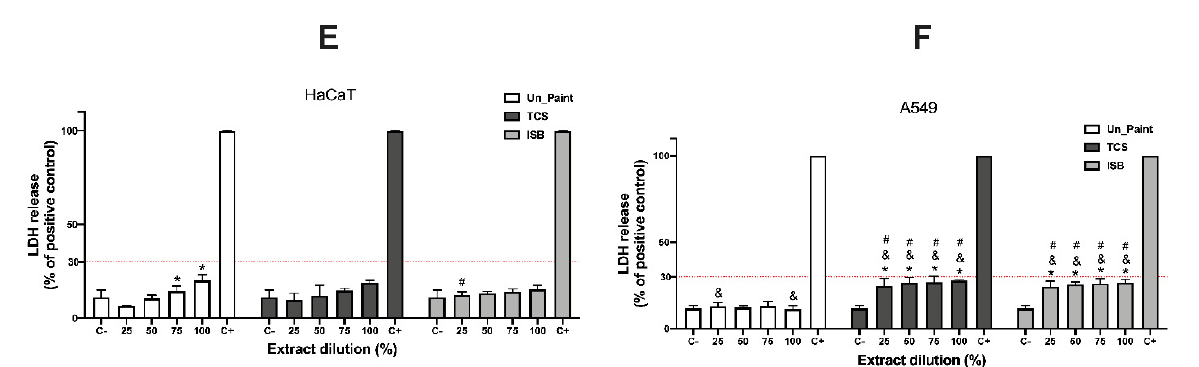
Figure 4. Results of WST-1 ( A , B ), NRU ( C , D ) and LDH ( E , F ) assays, with HaCaT and A549 cells, after 24 h incubation with the extracts (in the x axis) of the samples of Un_Paint, TCS and ISB extracts at concentration of 25, 50, 75 and 100%. C- negative control (assay medium), C+ positive control (Triton X-100 solution (1%) for WST-1 and LDH or SLS 0.2 mg/mL for NRU). The red lines represent the defined thresholds of acceptable values for each parameter, 70% for cellular viability and 30% for LDH leakage. The values are expressed as mean ± standard deviation. The statistical significance of the extracts compared to C- is represented by *, and the statistical differences compared to Un_Paint are represented by # (One-way ANOVA; p < 0.05). The statistical significance of the extract on A549 cells compared to the same extract, in the same concentration, on HaCaT cells is represented by & (Two-way ANOVA; p < 0.05).